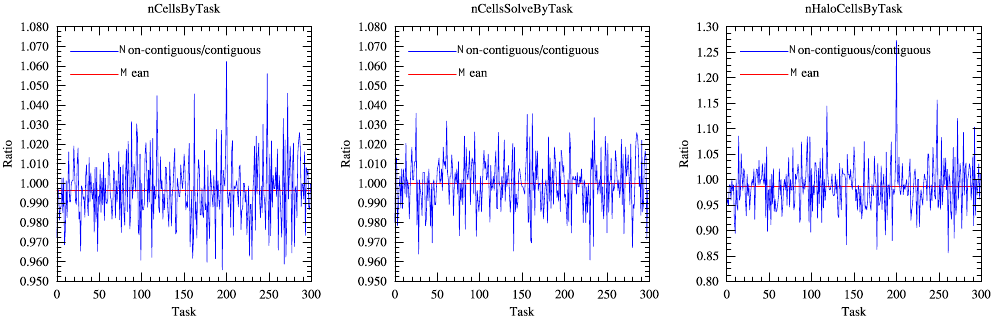
Figure 5. Ratio of (left) total number of cells, (middle) number of owned cells and (right) number of halo cells per task between the non-contiguous and the contiguous graph partition of the variable 100–25km mesh for 300 tasks.